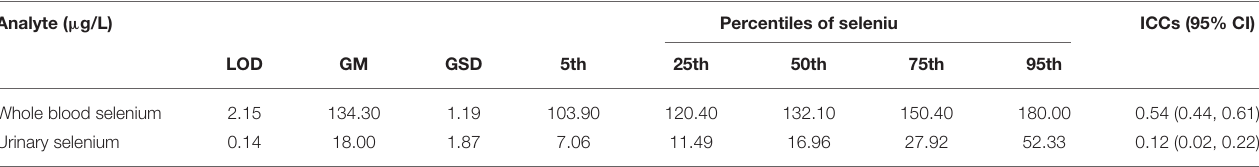
TABLE 2 | Limits of detection, distribution characteristics, and reproducibility of the selenium biomarkers. Analyte ( µ g/L)